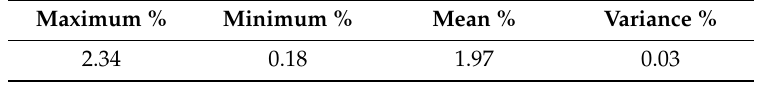
Table 5. Statistical parameters for water content of the block soil samples after drying process.